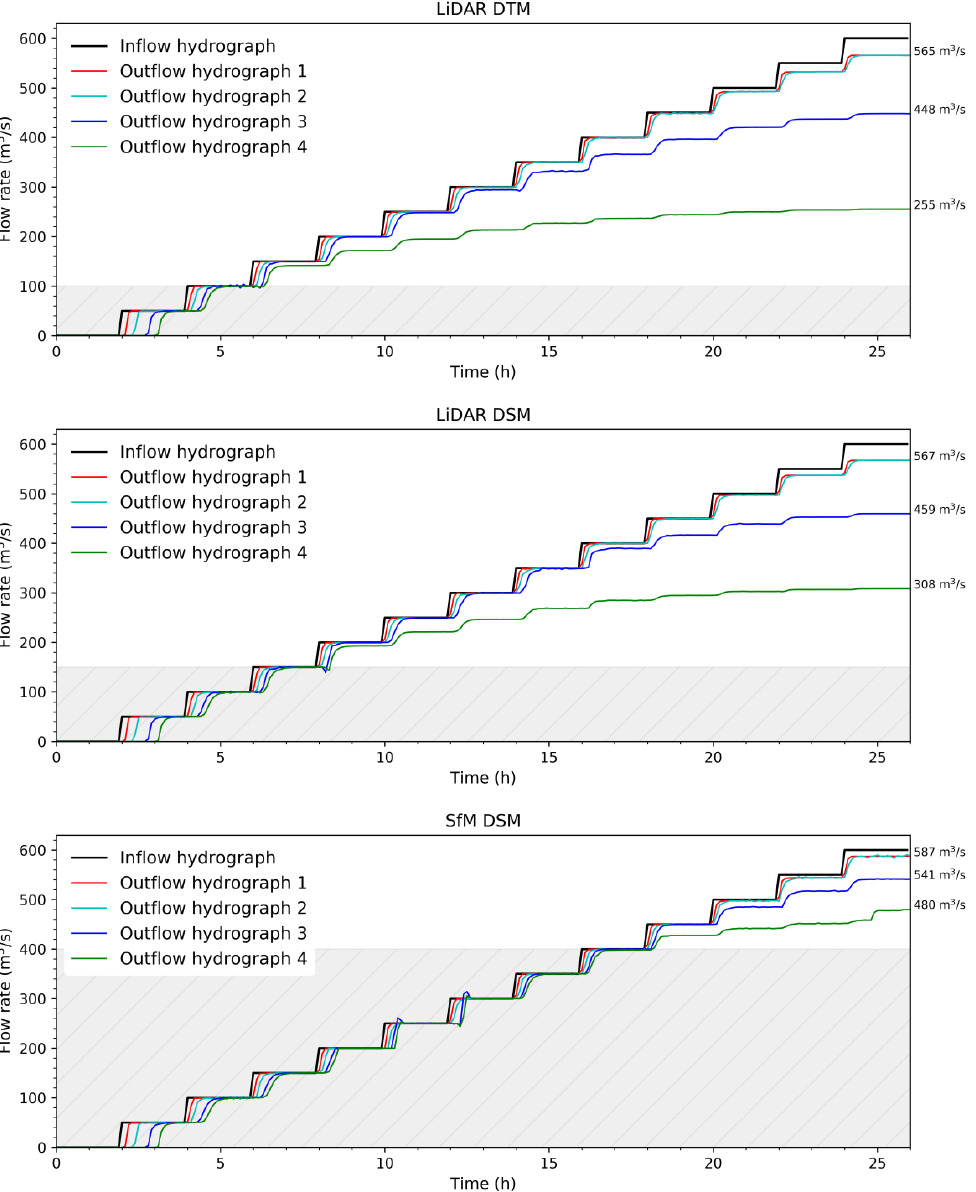
Figure 8. Flow rates computed using FLO-2D at four different sections (see Figure 2) for an input flow step function with 50 m 3 /s increments (maximum input rate 600 m 3 /s) in the simulations based on LiDAR DTM, LiDAR DSM, and SfM DSM. The shaded area highlights the flow rate range without flooding.